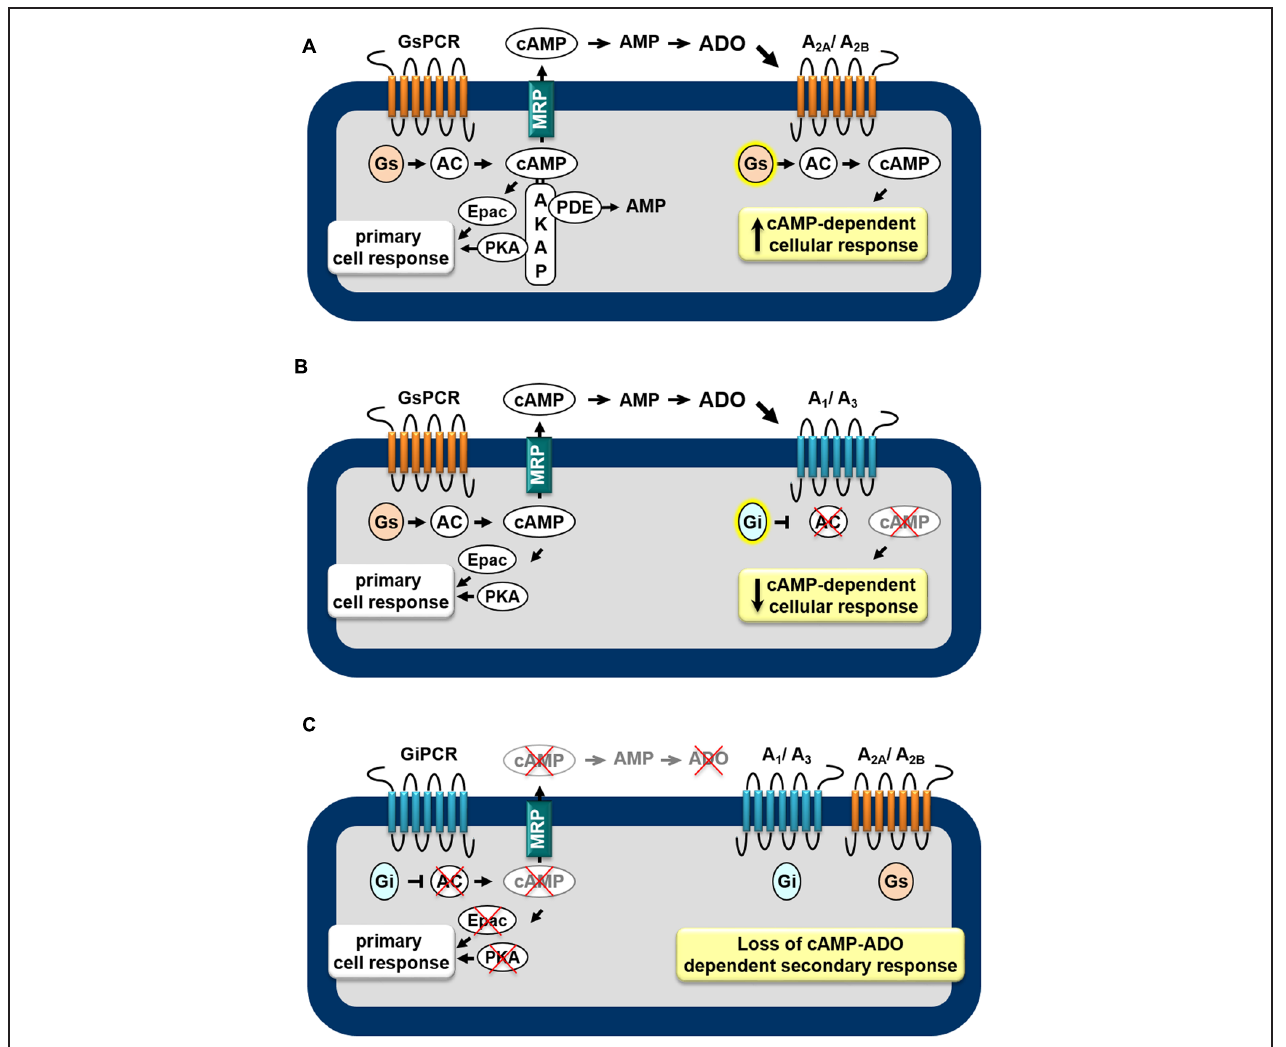
FIGURE 1 | Feedback mechanisms mediated by the extracellular cAMP–adenosine cascade. Activation of receptors coupled to Gs protein (GsPCR) leads to stimulation of adenylyl cyclase (AC) and increased generation of cAMP, which may elicit localized cellular response via activation of effectors such as PKA or Epac (A,B) , which are organized in microdomains via anchoring proteins, such as AKAP. cAMP may be hydrolyzed by intracellular phosphodiesterases (PDEs) or may leave the cell via multidrug resistance